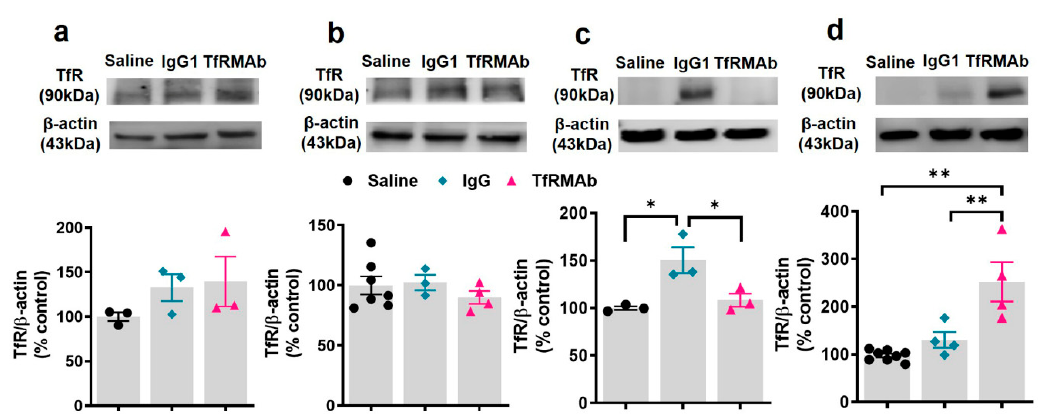
Figure 6. Transferrin receptor (TfR) protein levels following acute and chronic dosing of the high-a ffi nity bivalent TfRMAb in mice. Mice were treated with a single 3 mg / kg SQ dose or three days per week for four weeks with a 3 mg / kg SQ dose of TfRMAb, and brain ( a , b ) and spleen ( c , d ) TfR protein levels were measured. Whole brain tissue TfR protein after 24 h ( a ) and chronic ( b ) TfRMAb dosing. Spleen TfR protein after 24 h ( c ) and chronic ( d ) TfRMAb dosing. TfR levels were detected by Western blotting using a non-competing antibody against the TfR. Data are shown as the mean ± SEM of n = 3–8 per group. * p < 0.05, ** p < 0.01.